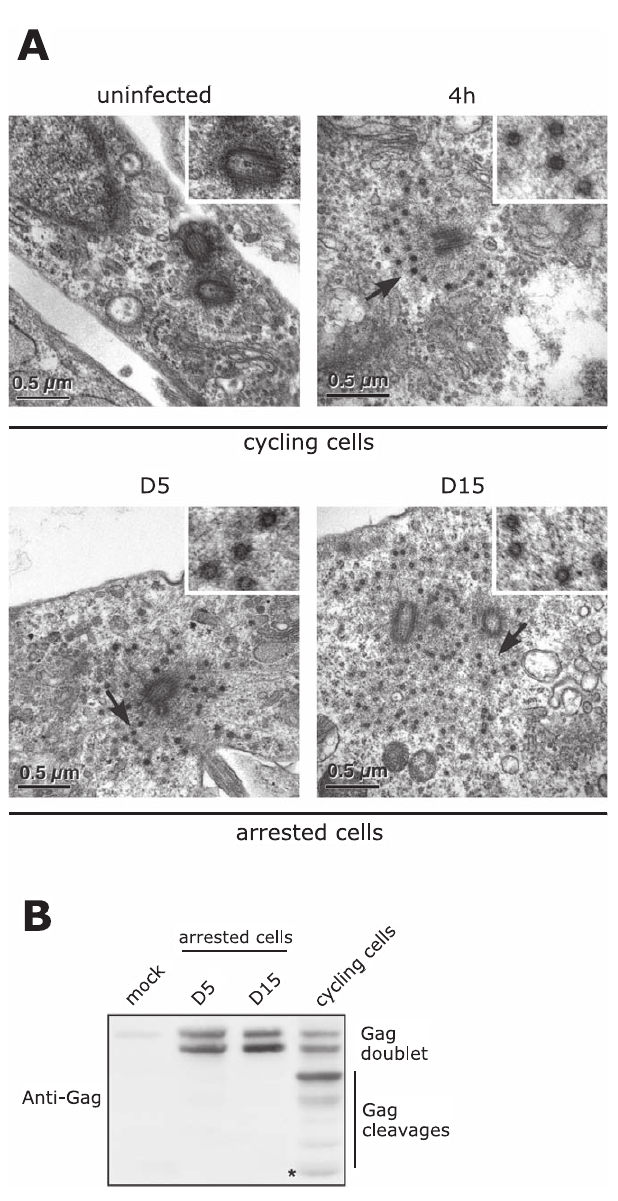
Figure 2. Characterization of Incoming PFV Particles in Resting MRC5 Cells (A) Electron micrographs of uninfected and infected cycling and resting cells. Normally shaped intracellular capsids (pointed out by a black arrow) are observed in PFV-infected cycling cells at 4 h p.i. In resting cells at 5 or 15 d p.i., similar intact capsids (pointed out by a black arrow) are observed surrounding the MTOC. High magnifications are presented in the right corner. No viral capsids are detected in uninfected cells. (B) Western blot analysis of protein extracts from PFV-infected cycling and resting cells using anti-Gag abs. Analysis of protein lysates performed 7 h p.i. in cycling cells reveals the presence of the characteristic Gag doublet (71–68 kDa) and early Gag cleavage products. The 38-kDa Gag product (*) results from the action of the viral protease. In resting cells, 5 or 15 d p.i., these shorter Gag products are absent.